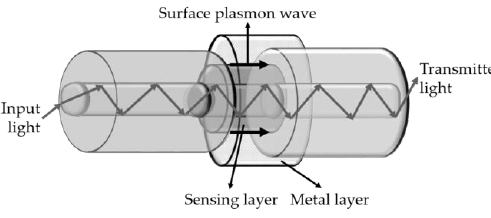
Figure 22. Schematic diagram of a typical optical fiber SPR-based sensor.